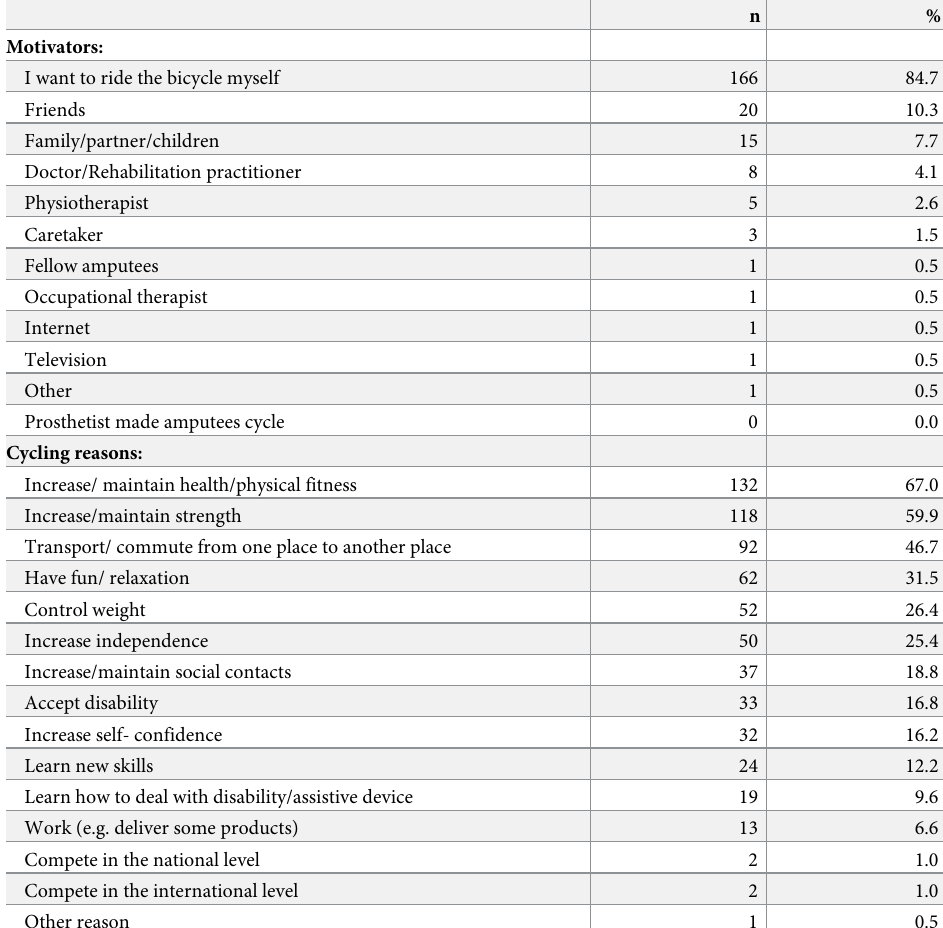
Table 3. Motivators and reasons of